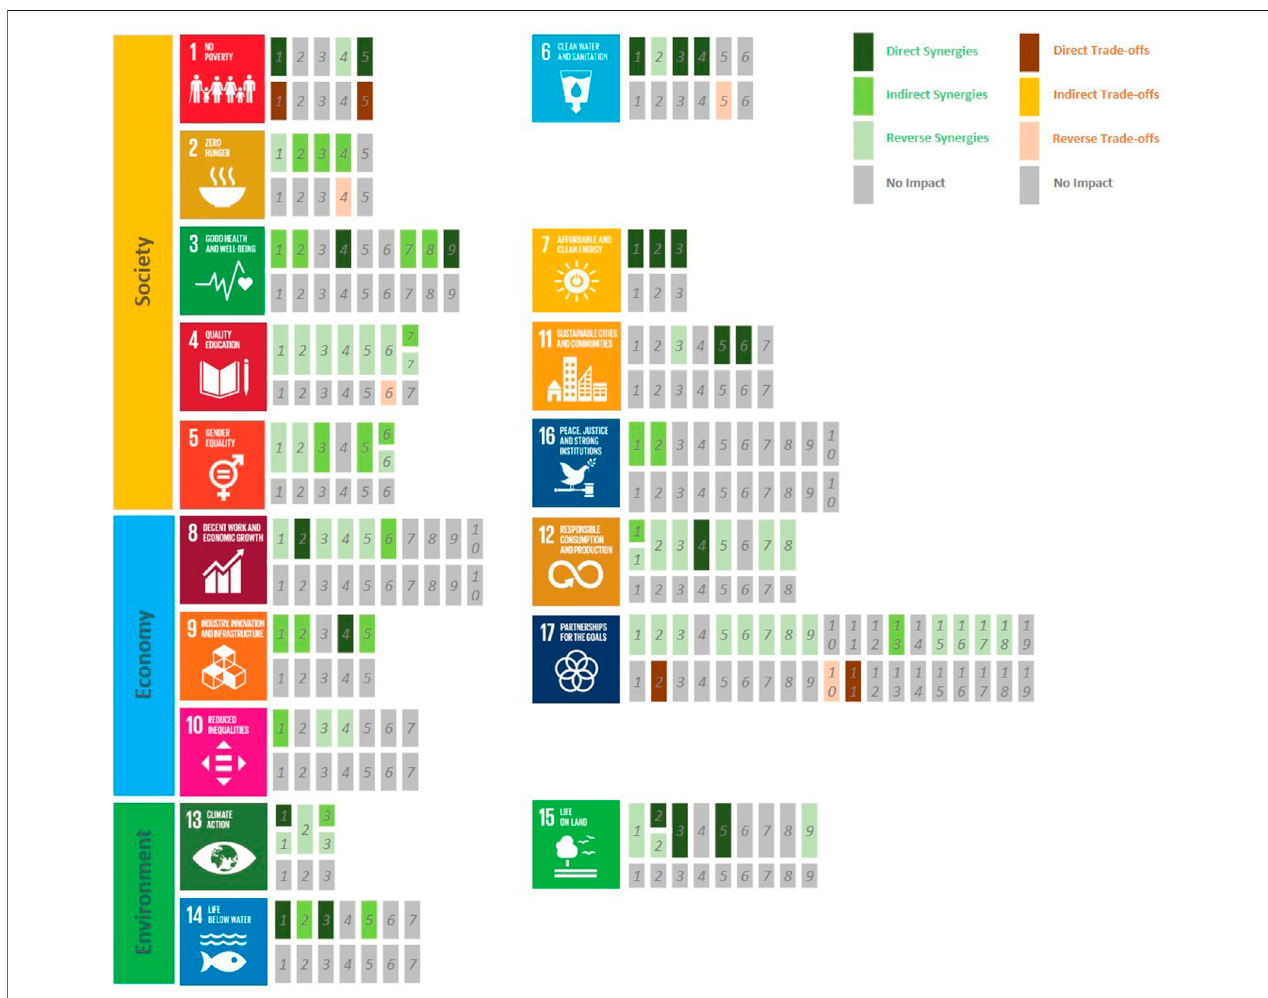
FIGURE2| Synergiesandtrade-offsofmitigatingnon-fossilmethaneemissionsfromtheagriculturalsectoron17UNSustainableDevelopmentGoals.Graphicsin the fi gure have been adapted from Nerini et al. (2019).